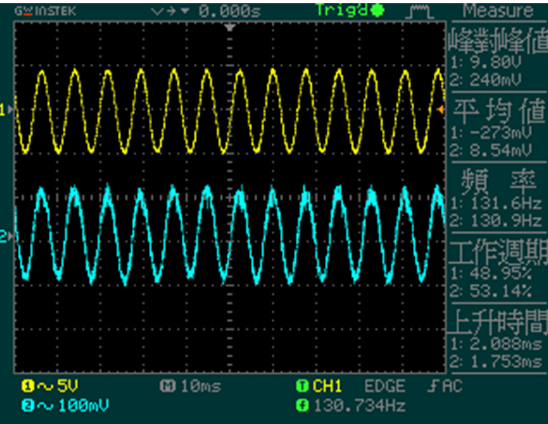
Figure 4. The comparison between the original electrical signal and the FBG hydrophone detecting signal shown in an oscilloscope. signal shown in an